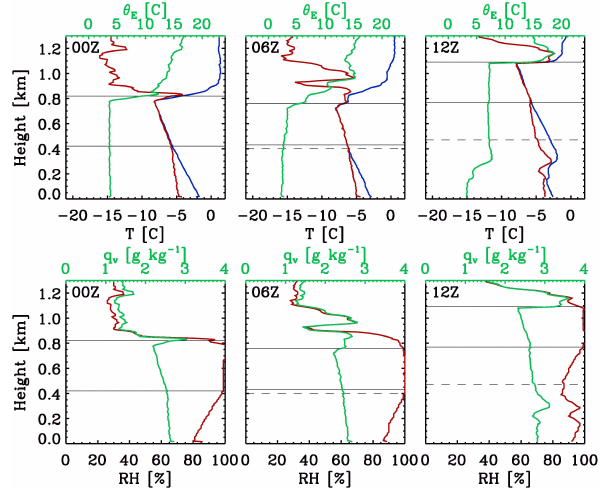
Fig. 4. Measurements from 0Z (left), 6Z (middle), and 12Z (right) soundings on 28 August 2008 (Case #1). Panels in the top row con- tain dry bulb (blue) and dew point (red) temperatures referenced to the lower axis and equivalent potential temperature (green) refer- enced to the upper axis. Panels in the lower row contain the relative humidity (red) referenced to the lower axis and specific humidity (green) referenced to the upper axis. In each panel, liquid cloud boundaries are designated by horizontal solid lines, while the ap- proximate base of the cloud-driven mixed layer is designated by a horizontal dashed line (and the mixed-layer base is assumed to be at the surface during the 0Z sounding). Soundings are launched about 30min prior to the nominal sounding